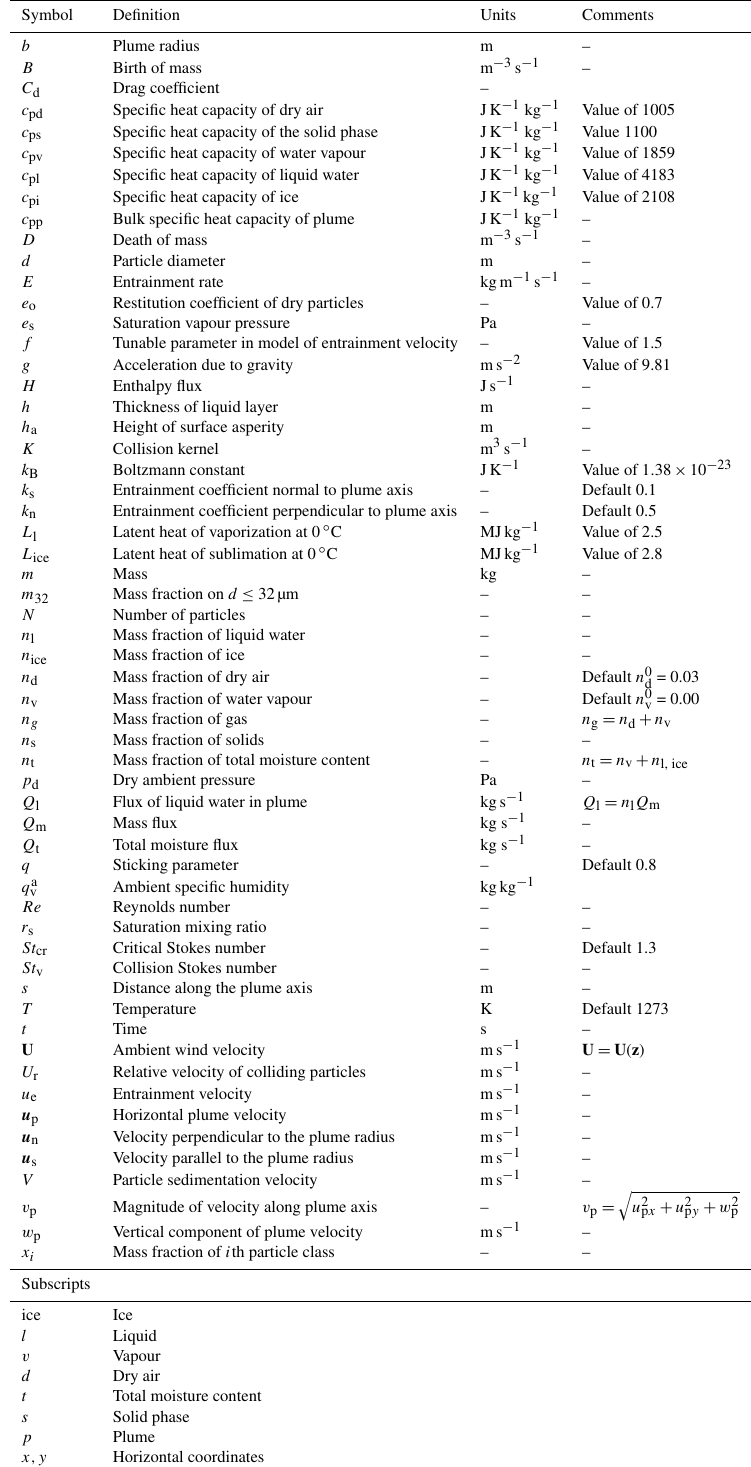
Table 1. List of Latin symbols. Quantities with a superscript of 0 indicate values at the